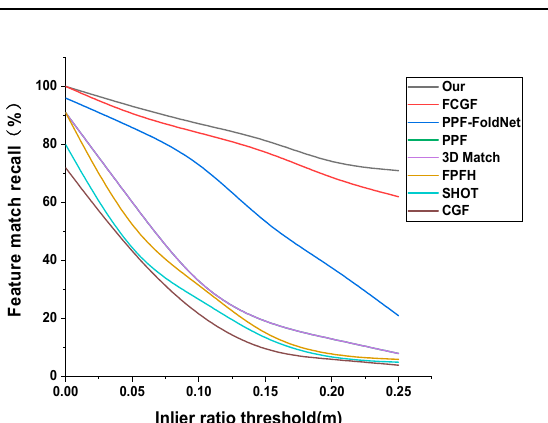
Figure 5. The influence of different internal ratio thresholds on feature match recall.